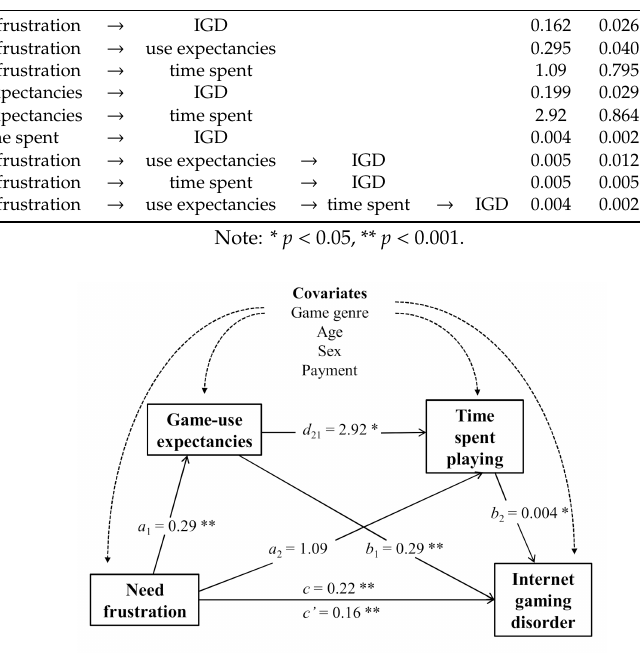
Figure 2. Results of the serial mediation model of the association between need frustration and Internet gaming disorder (* p < 0.05, ** p <